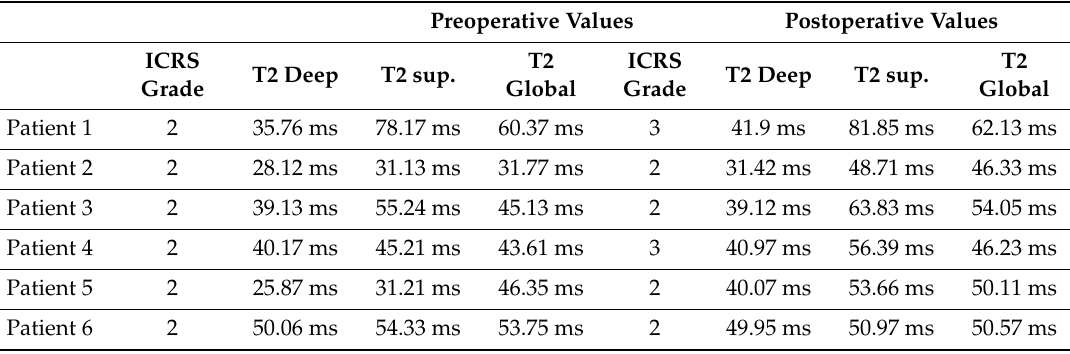
Table 2. Preoperative and one-year postoperative grading of cartilage defects on morphological MRI according to the ICRS classification system, as well as absolute pre- and postoperative T2 values for each patient. Morphological MRI underestimates the degree of postoperative cartilage